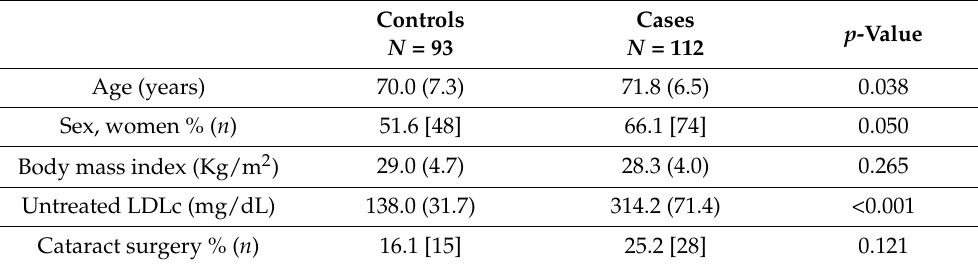
Table 1. Clinical and laboratory characteristics of controls and